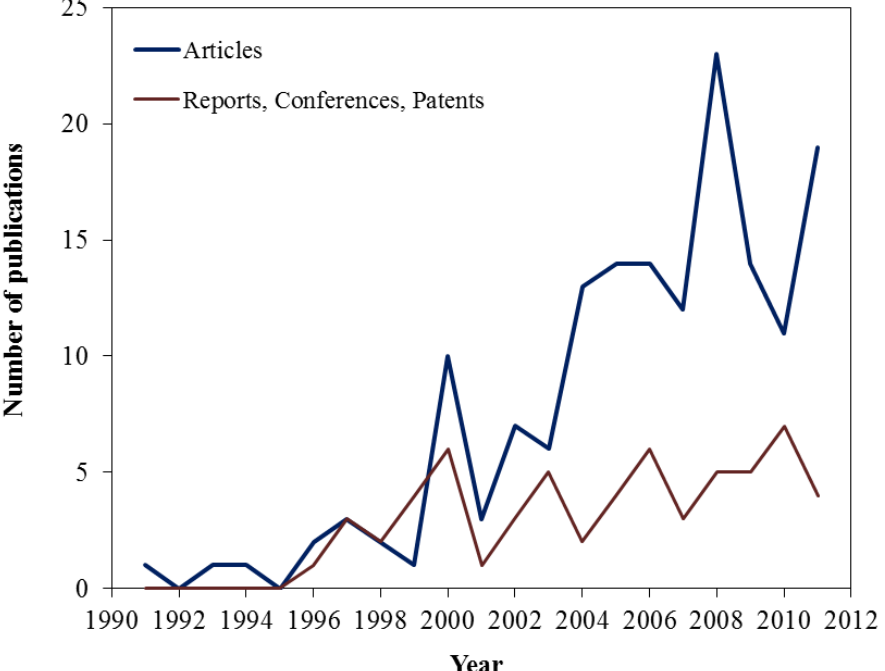
Figure 1. Yearly Frequency of Published Literature on Mercury